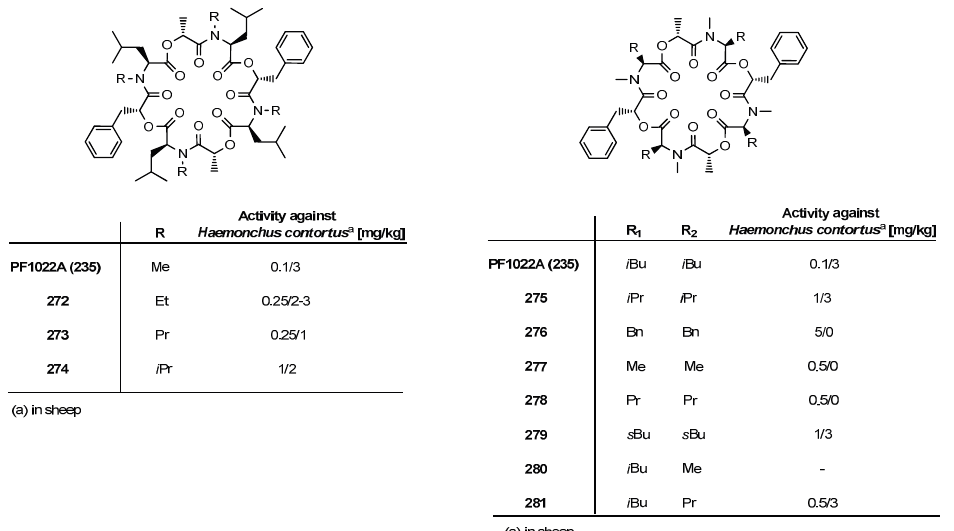
Figure 28. Biological activity of various PF1022A-derivatives.